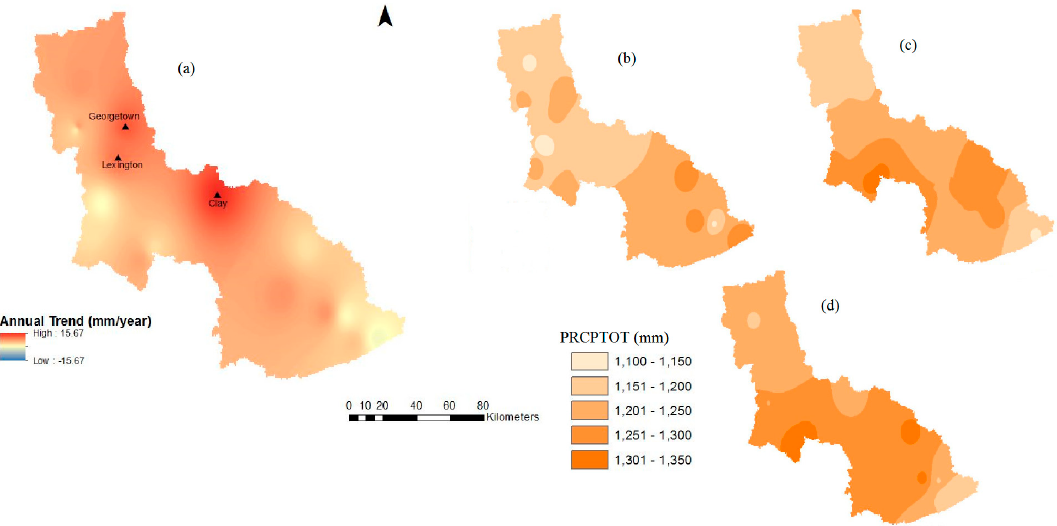
Figure 5. Spatial distribution of PRCPTOT ( a ) trend and mean values under: ( b ) baseline; ( c ) late ‐ century RCP 4.5; and ( d ) late ‐ century RCP 8.5, in the Kentucky River Basin. Filled triangles indicate a statistically significant ( p < 0.05) trend.